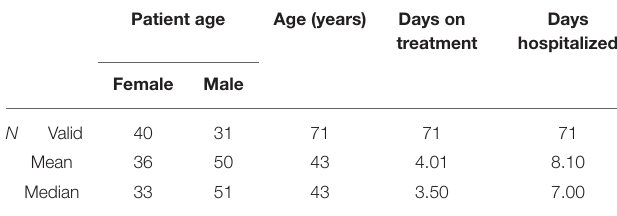
TABLE 1 | Study patient demographics.